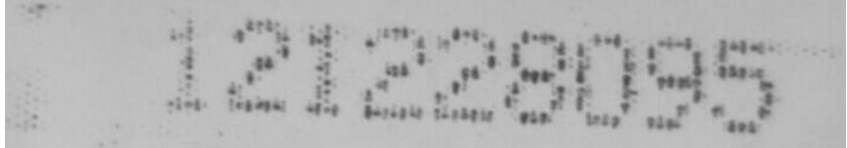
Fig. 3. Zoom in for the dashed region in Fig.